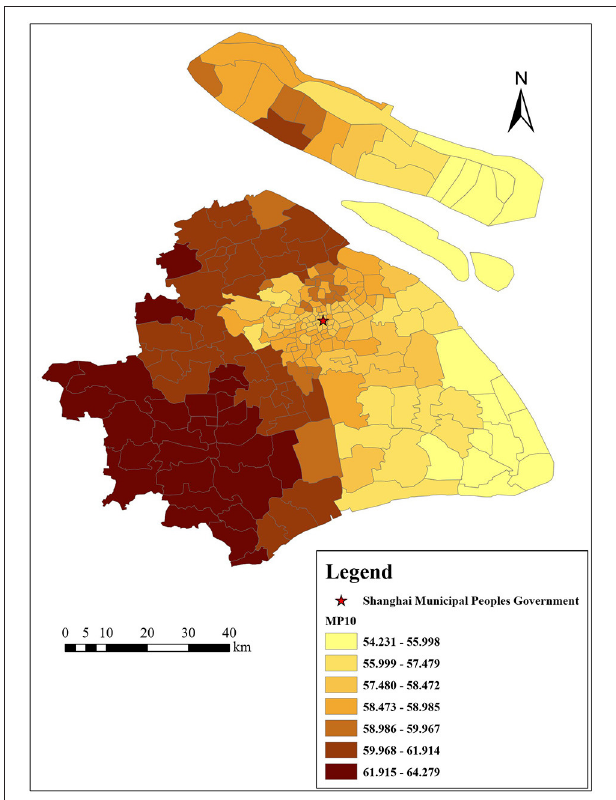
FIGURE 6 | Distribution of PM 10 ( µ g/m 3 ) in